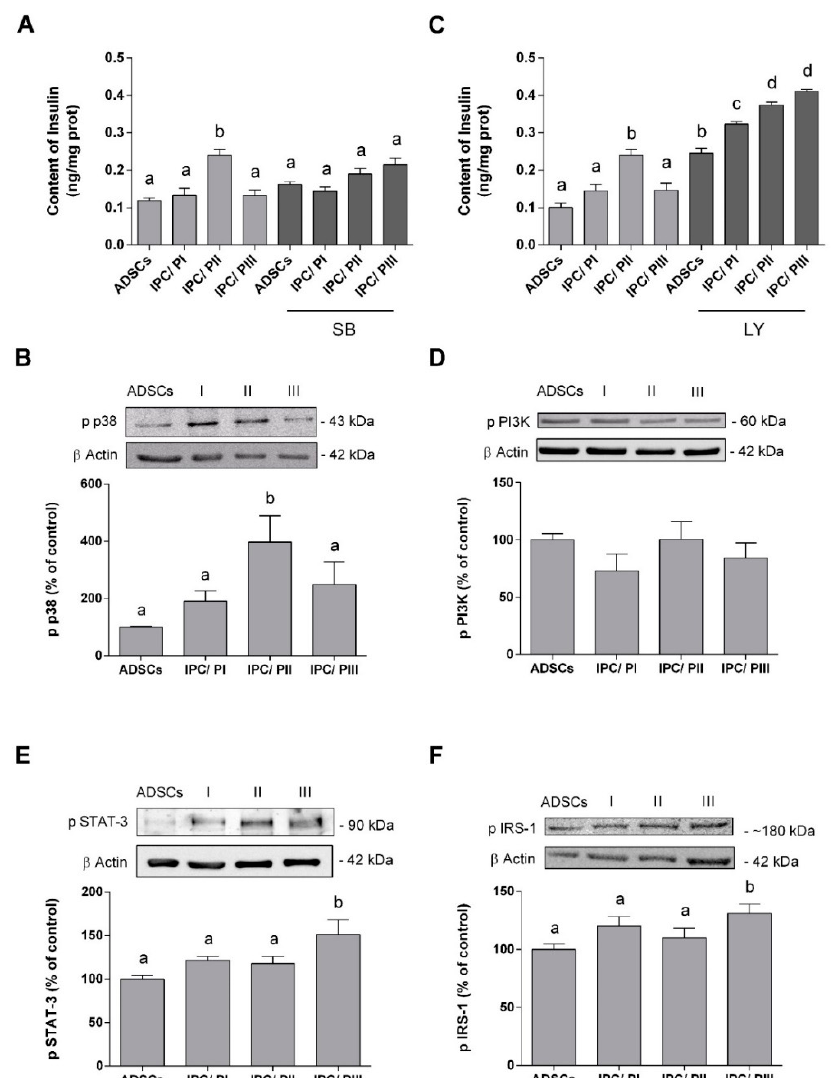
Figure 5. p38 / MAPK, PI3K, Jak / STAT-3, and IRS-1 signaling pathways during the di ff erentiation of ADSCs into IPCs. ( A ) Insulin content in ADSCs and IPCs (di ff erentiated by three di ff erent protocols), incubated or not in the presence of SB203580 (at 10 µ M), an inhibitor of p38 / MAPK. ( B ) p38 / MAPK phosphorylation in ADSCs and IPCs, as measured by Western blotting. Representative Immunoblots are shown in the inset. ( C ) Insulin content in ADSCs and IPCs (di ff erentiated by three di ff erent protocols), incubated or not in the presence of LY294002 (at 10 µ M)—a PI3K inhibitor. ( D ) PI3K phosphorylation in ADSCs and IPCs, as measured by Western blotting. Representative Immunoblots are shown in the inset. ( E ) STAT-3 phosphorylation content was analyzed by Western blotting in ADSCs and IPCs (di ff erentiated by three di ff erent protocols). ( F ) IRS-1 phosphorylation content was analyzed by Western blotting. Data are expressed as means ± SE of 6 independent experiments performed in triplicate. Letters indicate di ff erent statistical groups by ANOVA followed by Tukey’s test, assuming p < 0.05. Phosphorylation of STAT3 and the insulin-signaling pathway was assessed by Western Blotting (Figure 5E). An increase in STAT-3 phosphorylation (p = 0.0152; f (3.20) = 4.434) occurred only in the IPCs submitted to PIII. As such, we determined whether autocrine insulin signaling was also a ff ected by this resveratrol-induced increase in STAT-3 phosphorylation. IRS-1 phosphorylation (at serine-307) in IPCs submitted to PIII was found to be increased (Figure 5F, p = 0.0423; f (3.20) = 3.278), but no changes were observed in the IRS-1 in any of the cells (data not